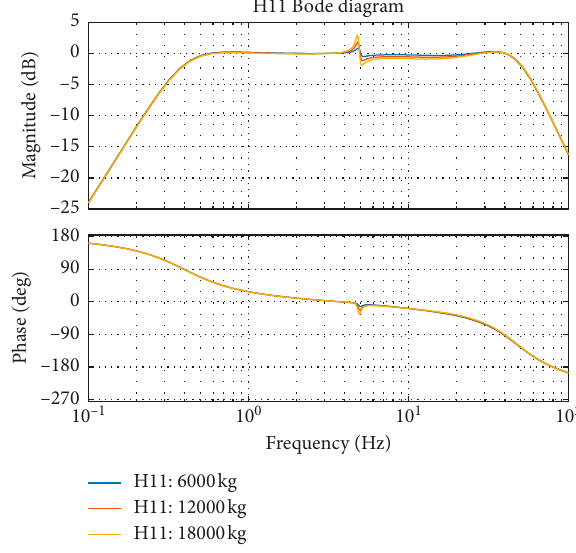
Figure 3: Effect of specimen’s mass on frequency response of H